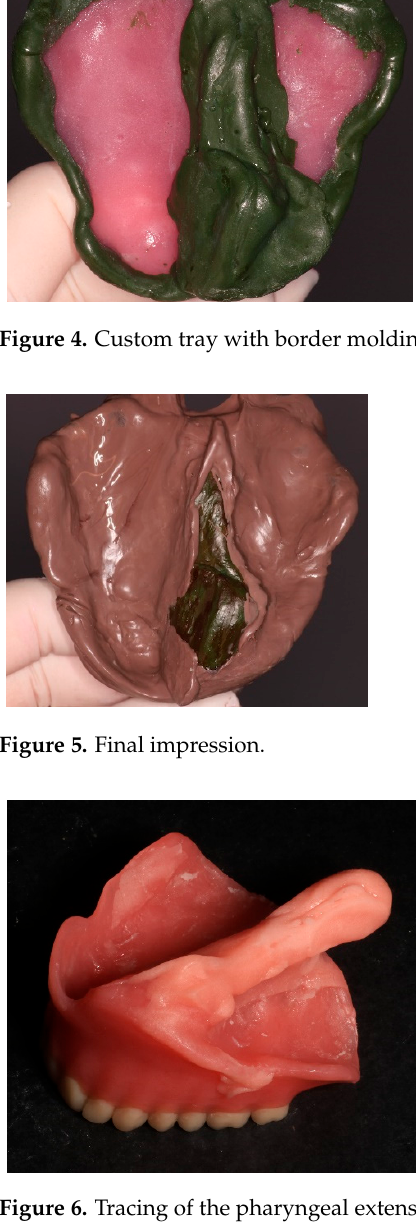
Figure 7. Definitive maxillary and mandibular prostheses delivered to the patient.